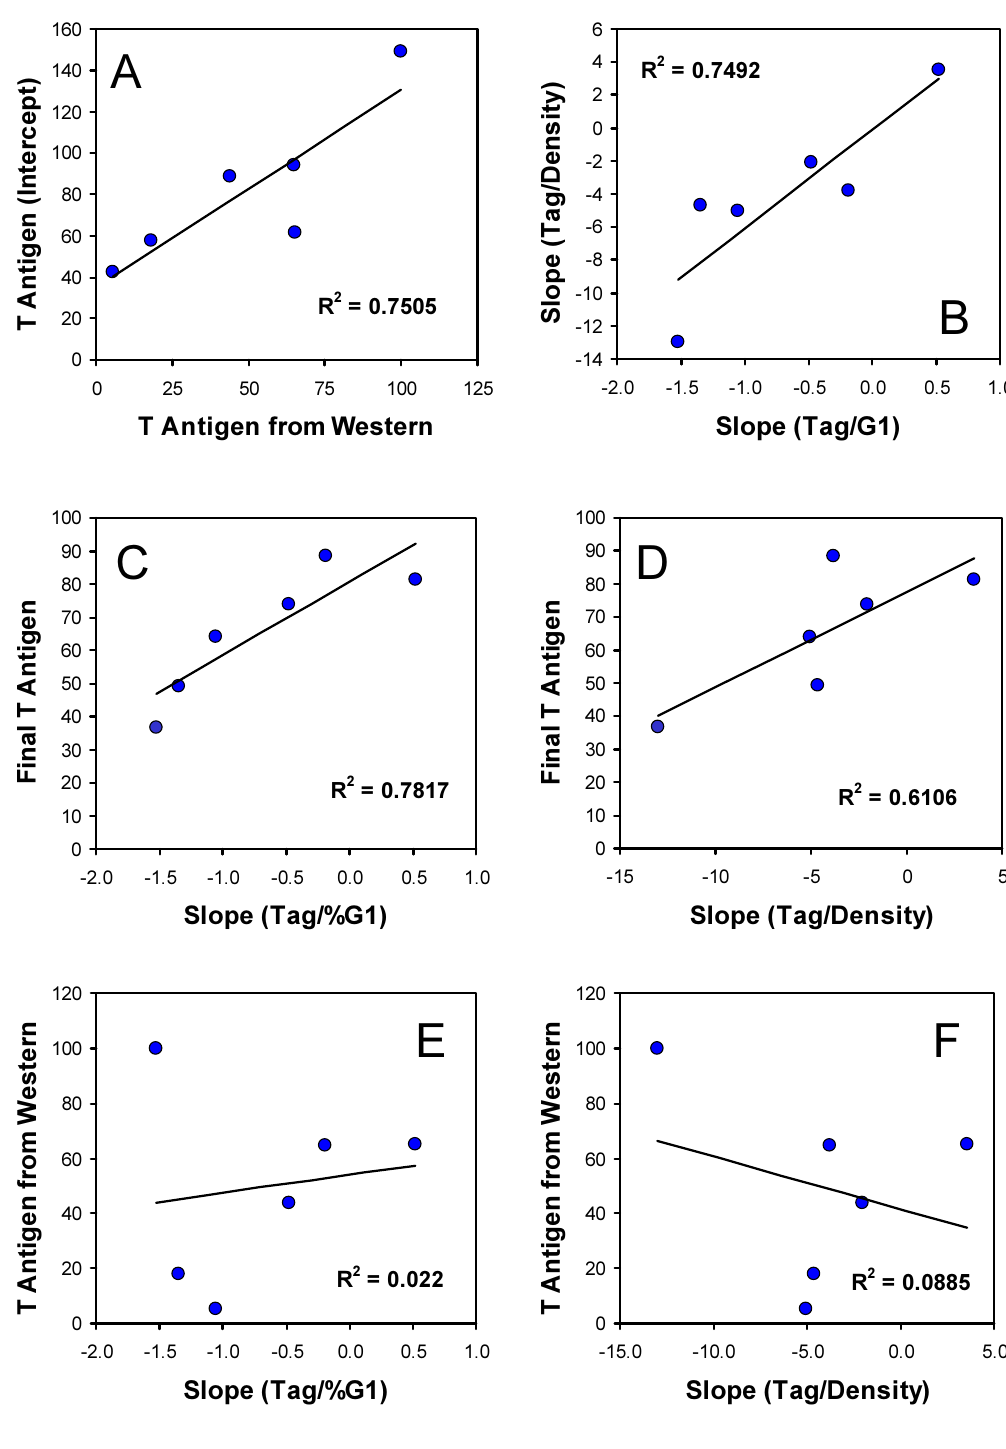
Figure 8 Relationships between Tag and density or growth phase effects. (see